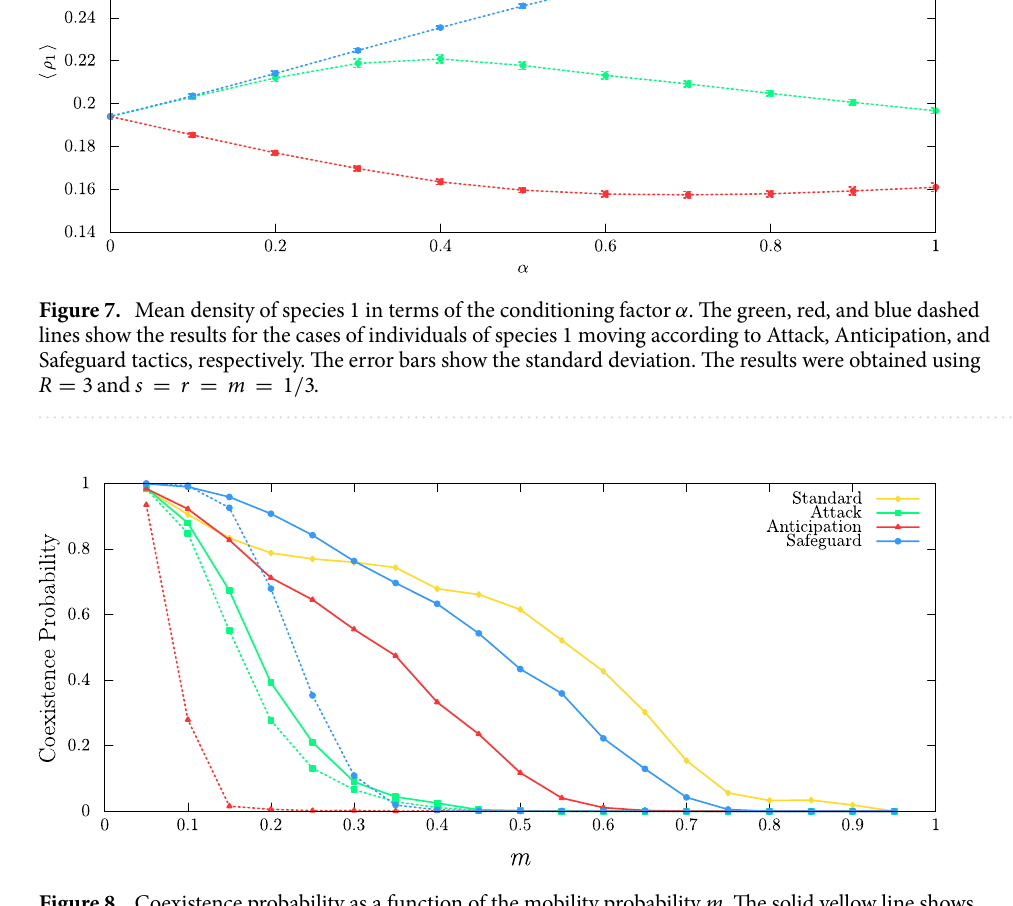
Figure 8. Coexistence probability as a function of the mobility probability m . The solid yellow line shows the coexistence probability for the standard model. The green, red, and blue lines show the results for the case of individuals of species 1 moving according to Attack, Anticipation, and Safeguard directional tactics, respectively. Solid lines and dashed lines show the results for R = 2 and R = 4 , respectively. The results were obtained by running 2000 simulations in lattices with 100 2 grid points running until 100 2 generations, with s = r = ( 1 − m )/ 2